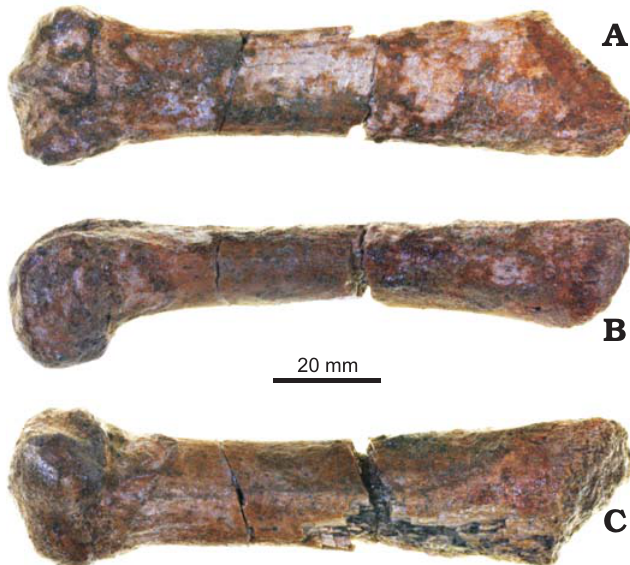
Fig. 4. Metacarpal of pinniped mammal Enaliarctos mealsi Mitchell and Tedford, 1973 (UCMP 276804) from Schooner Gulch, Mendocino County, California, earliest Miocene; in dorsal ( A ), lateral ( B ), and ventral/palmar ( C ) views.